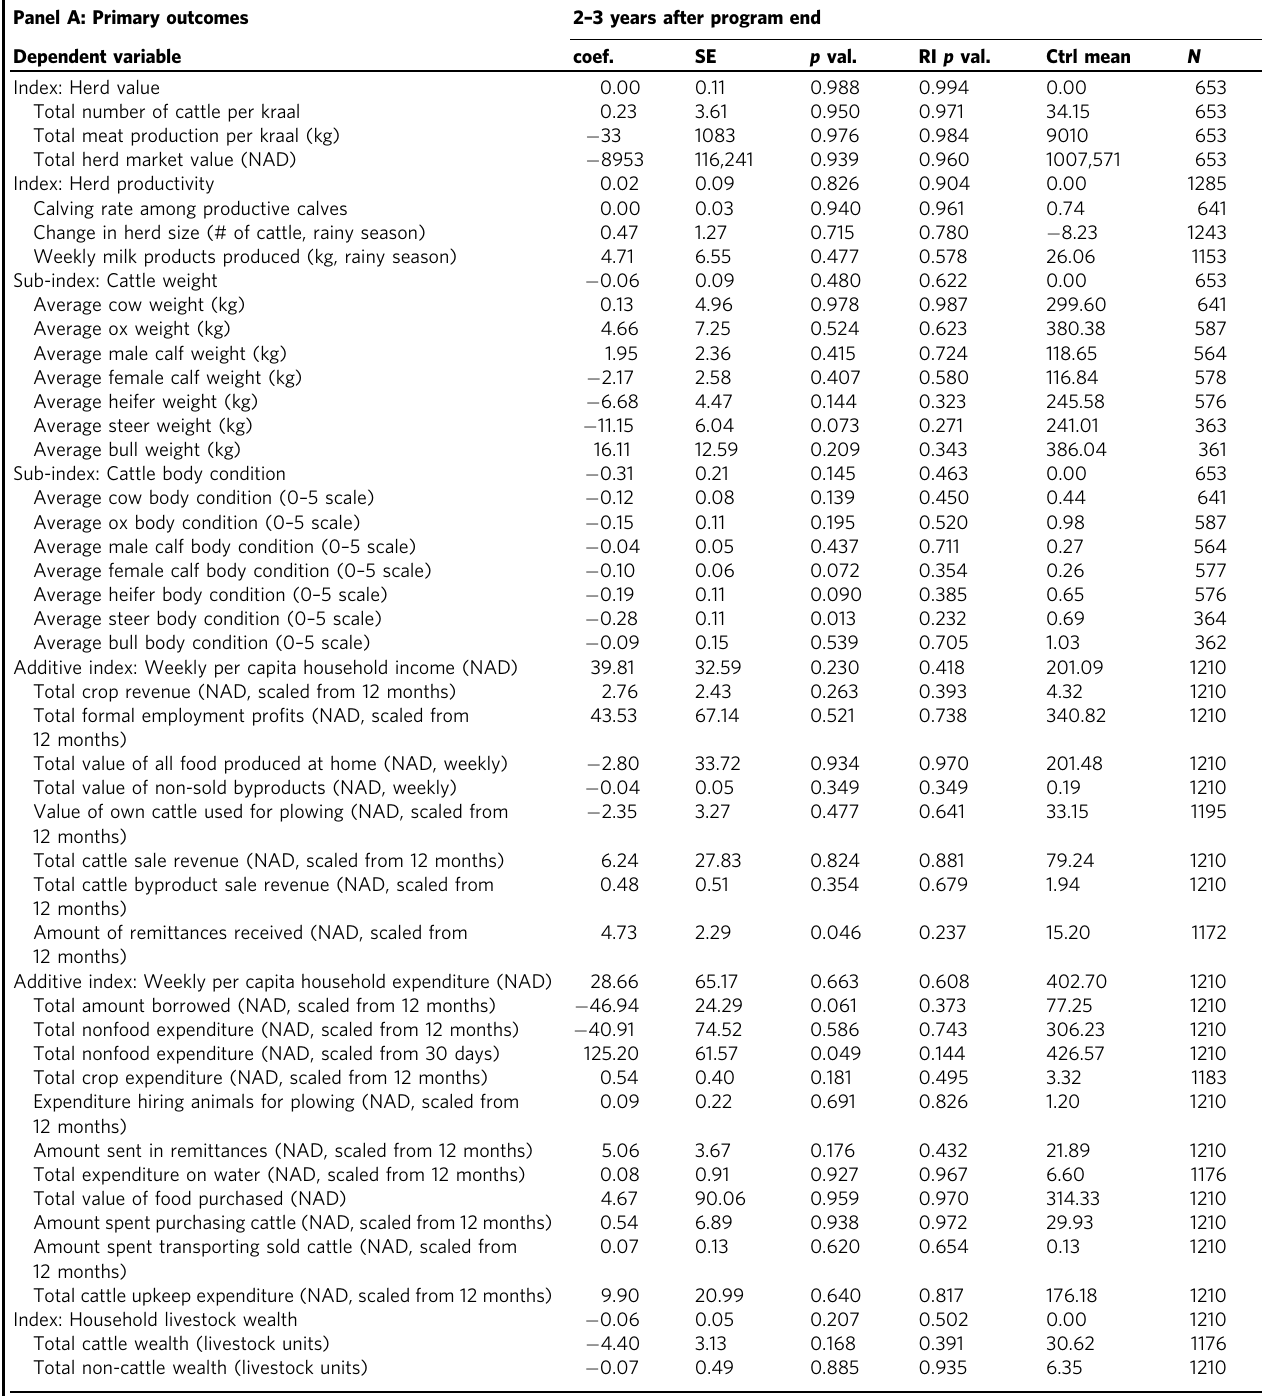
Table 5 Treatment effect on indices of rangeland health, cattle productivity and household economics, and their components (Panel